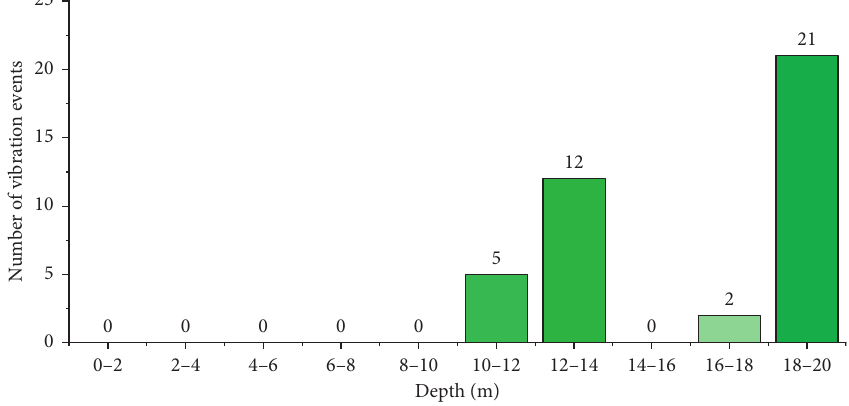
Figure 5: Number of vibration events at different drilling depths.